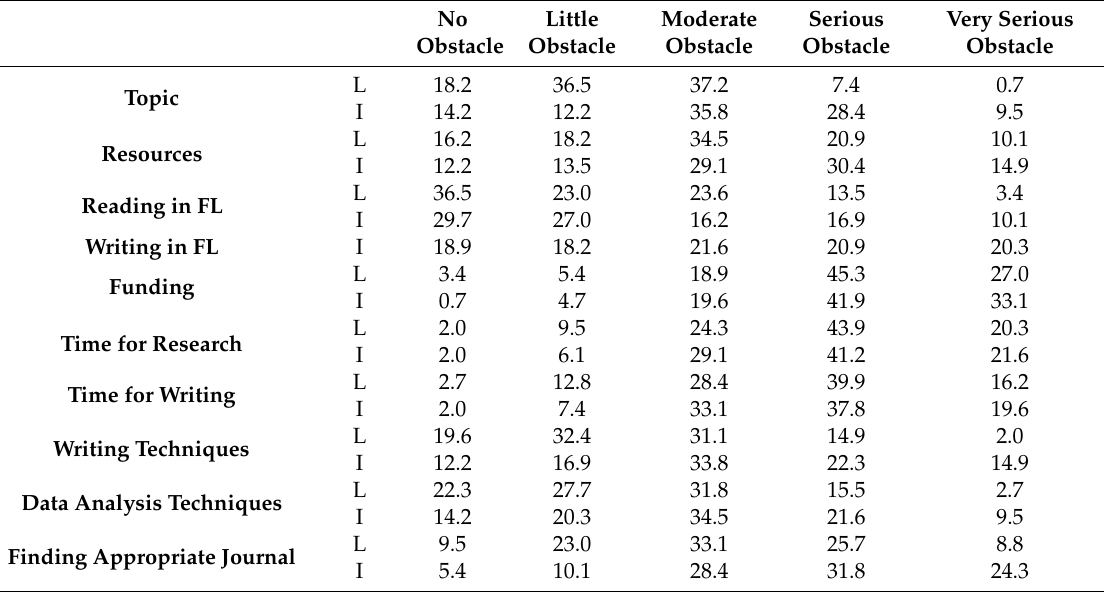
Table 6. Percentages of lecturers with various obstacles to local and international publication.